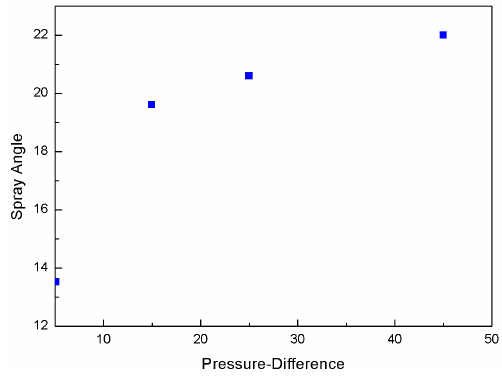
Figure 11. Variation of spray angle with respect to pressure difference.